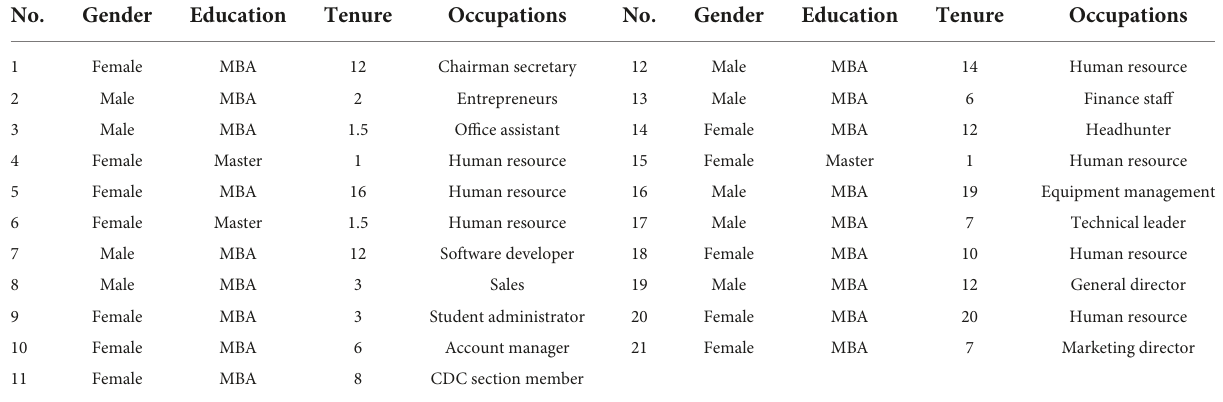
TABLE 1 Sample basic information of